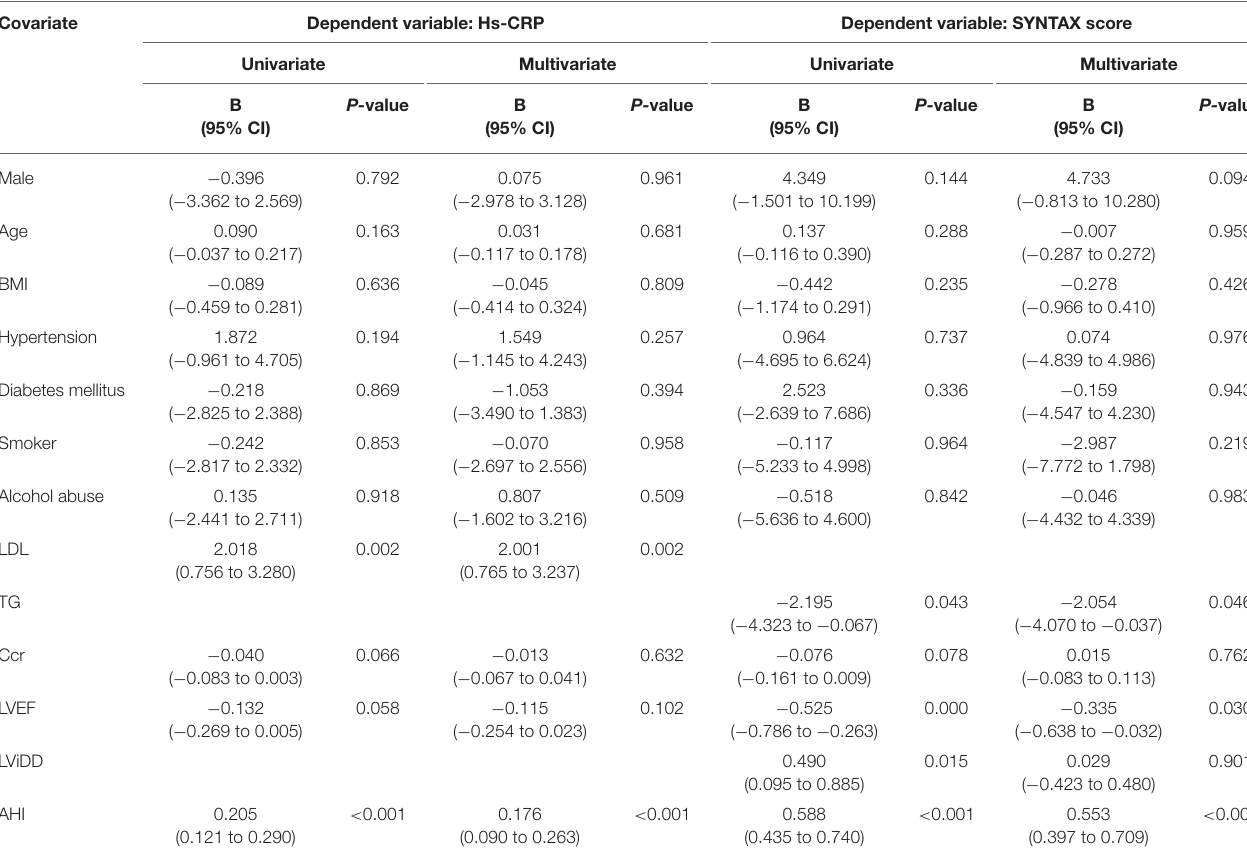
TABLE 7 | Univariate and multivariate linear regression analysis for the independent influencing factors of hs-CRP level and SYNTAX score. Covariate Dependent variable: Hs-CRP Dependent variable: SYNTAX score Univariate Multivariate Univariate